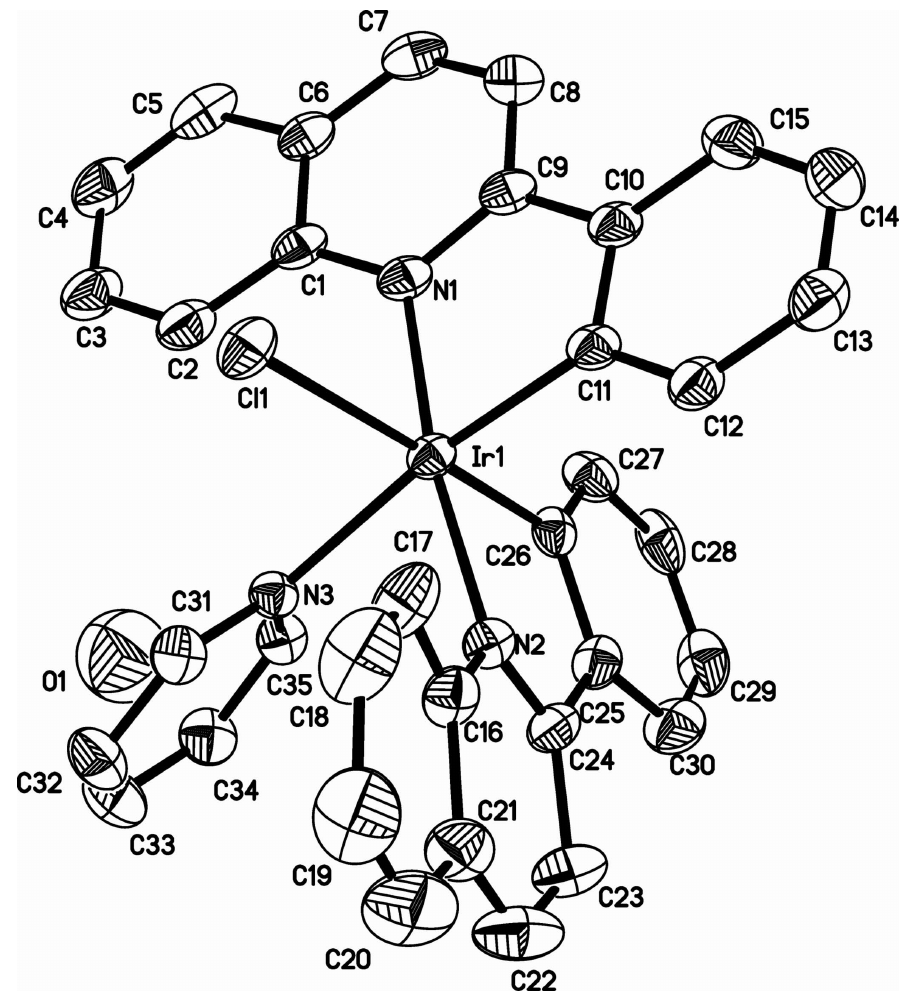
Molecular structure of the title compound. Displacement ellipsoids are drawn at the 50% probability level. H atoms have been omitted for